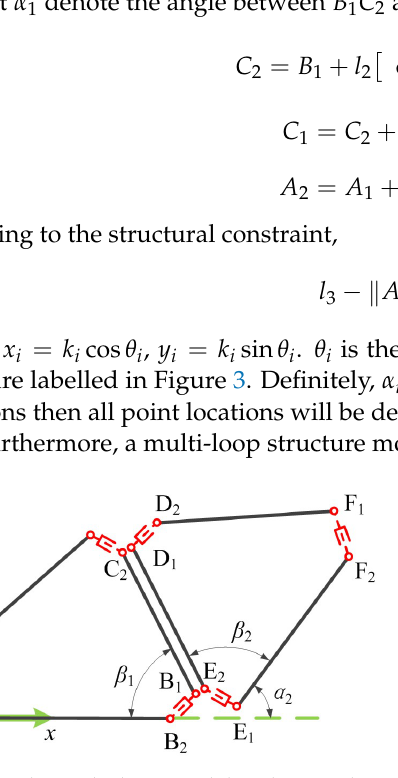
Figure 4. The multi-loop model with joint